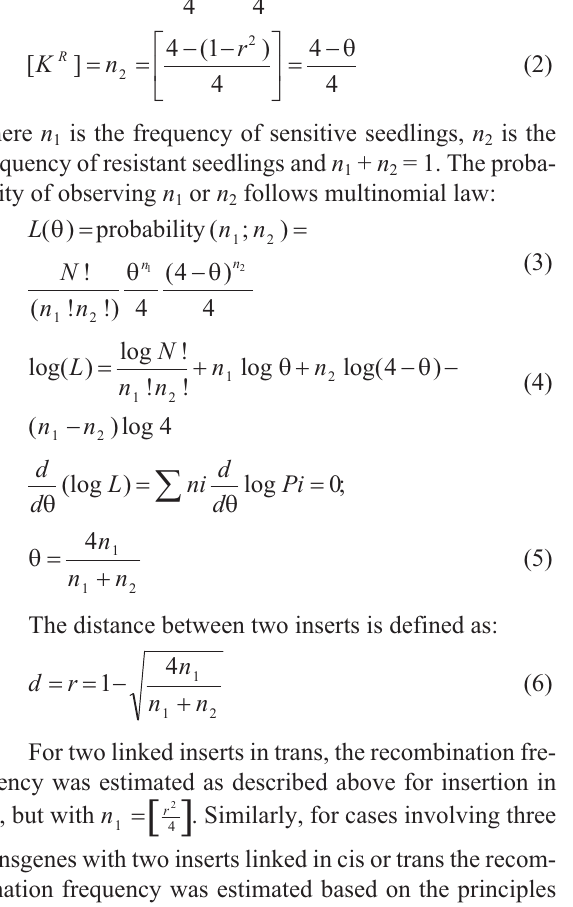
Table 2 - Estimation of ‘ r ’ in different cases of linkage.